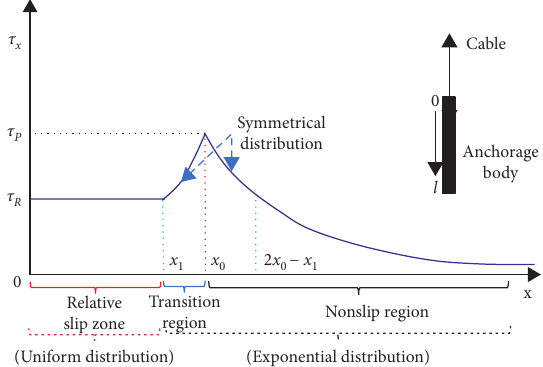
Figure 8: The shear stress distribution for the uniform index compound pattern.